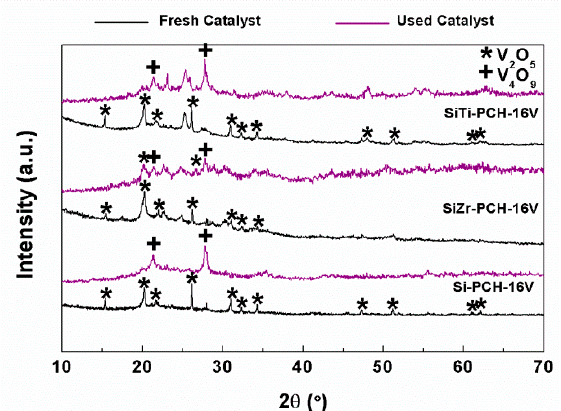
Figure 8. Comparison of the X-ray diffractograms of the Si-PCH16, SiZr-PCH-16V and SiTi-PCH-16V catalysts before and after selective oxidation of H 2 S reaction. Reaction conditions: 0.05 g of catalyst; total flow of 130 mL min − 1 ; reaction temperature of 180 °C; H 2 S/air/He molar ratio of 1.2/5.0/93.8.